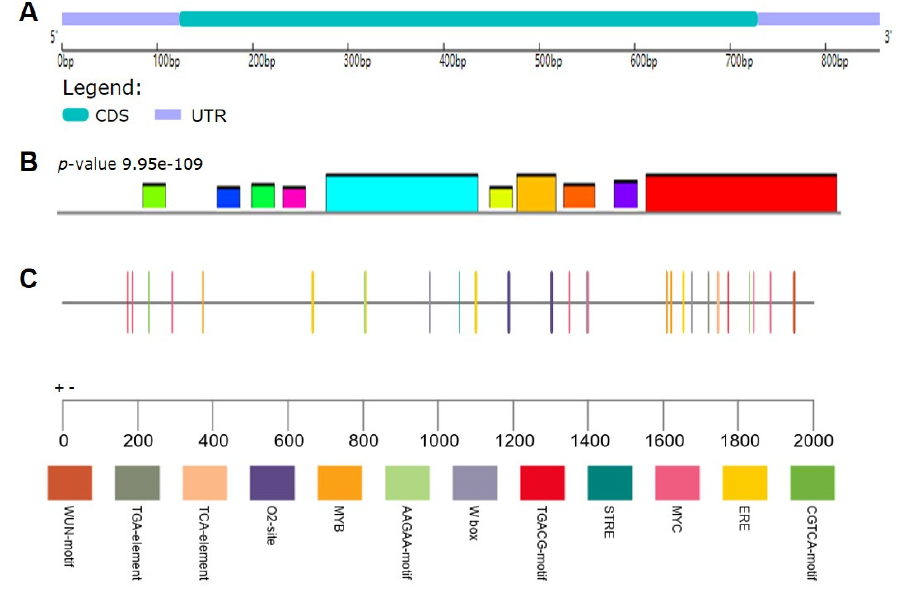
Figure 2. Characters of SlCML39 . ( A ) SlCML39 in the tomato genome. The SlCML39 gene structure was visualized using GSDS 2.0. ( B ) The SlCML39 motif was analyzed using the MEME web server. ( C ) Cis-element analysis of SlCML39 promoter. The cis-element of SlCML39 promoter was analyzed by PlantCARE database. All elements are shown in Supplementary Table S1.